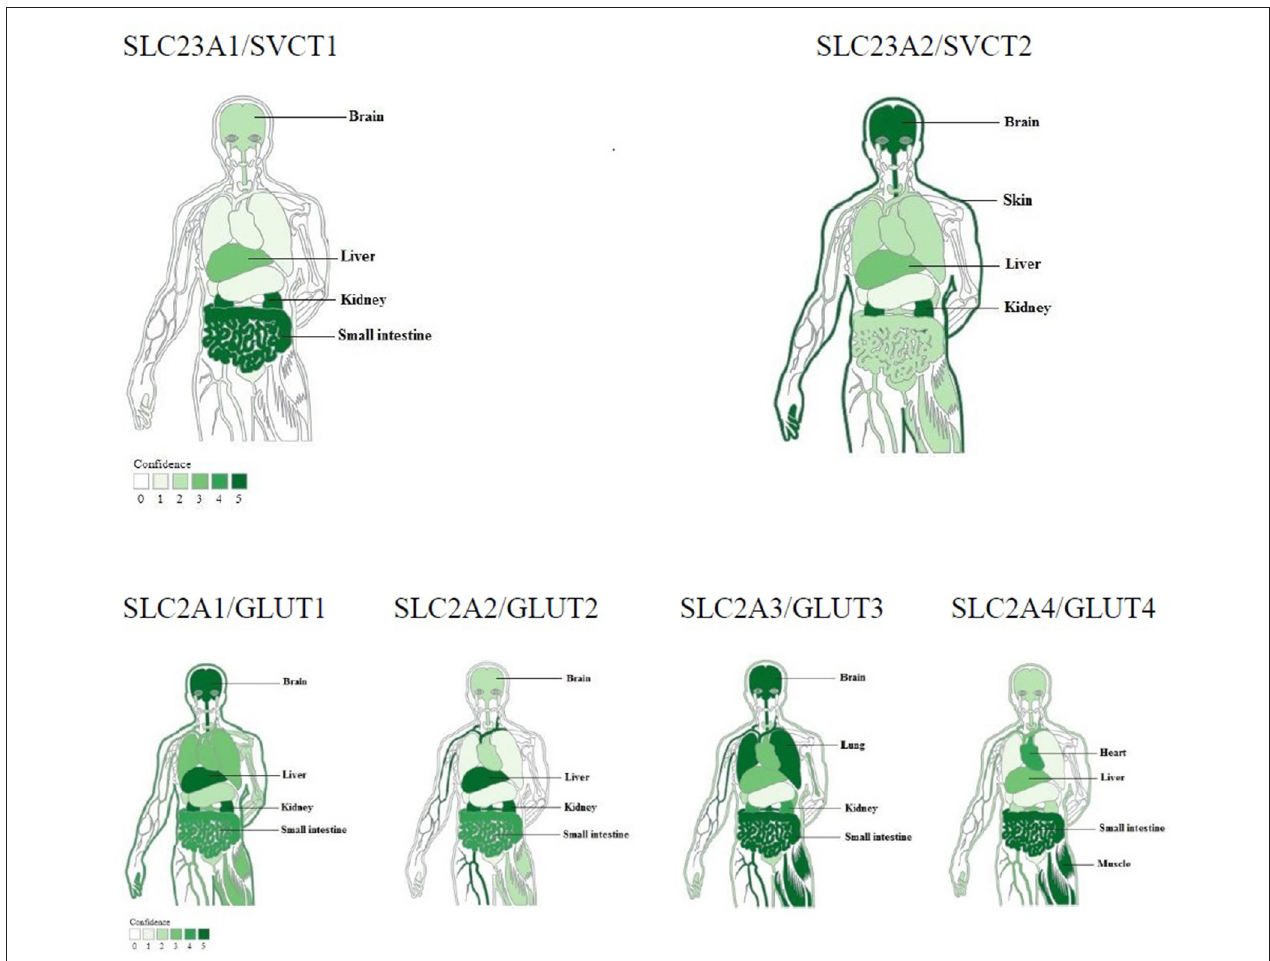
FIGURE 1 | Tissue expression of ascorbic acid or DHA transporters responsible for tight control of vitamin C concentrations (modified from TISSUES: Tissue expression database). Ascorbic acid transporters: sodium-dependent vitamin C transporters 1 and 2. DHA transporters: Glucose transporter 1 ∼ 4. Top four tissues with higher expression abundance were labeled for each